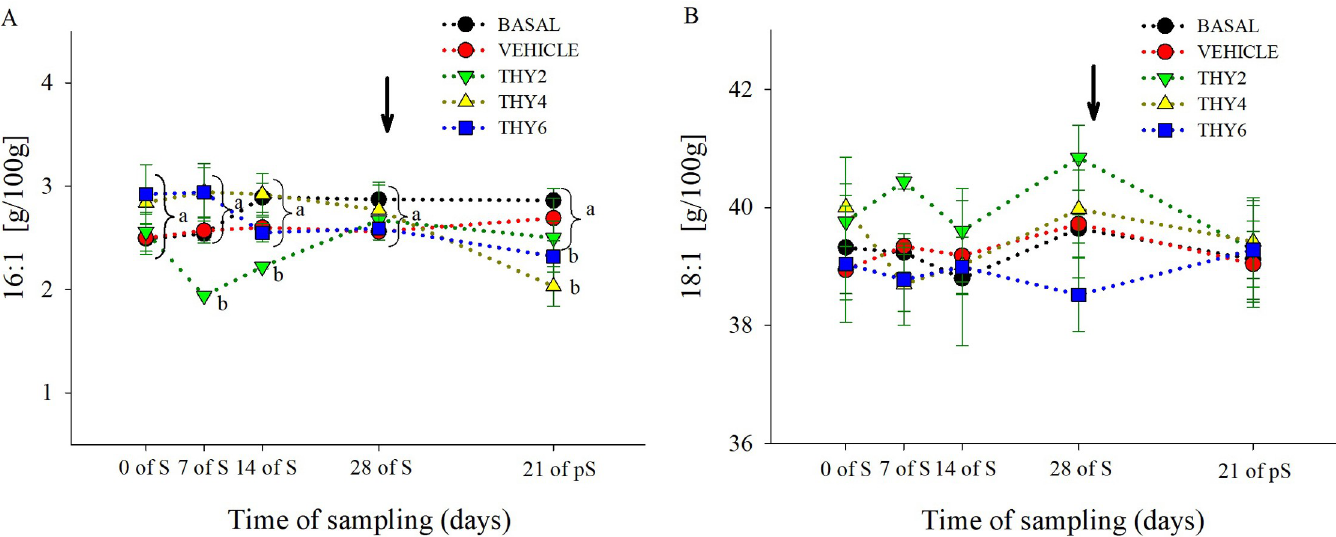
Fig 5. Concentration of monounsaturated fatty acids of quail egg yolk. Mean ± SEM of content (g/100 g FAME) of (A) palmitoleic (16:1) and (B) oleic acids (18:1) of quail egg yolk laid by females fed on the control diets (BASAL and VEHICLE) or supplemented with 2, 4, and 6.25 g of thymol/kg of feed (THY2, THY4 and THY6, respectively) at 0, 7, 14, and 28 days of the supplementation period (S) and after 21 days of supplement withdrawal (pS). Arrow pointing down indicates the end of the S period. Different letters (a, b) indicate statistical differences. Brackets refer to measurements within a time of sampling. The same 25 females (5 per diet supplied) were analyzed on each of the five sample points (125 eggs